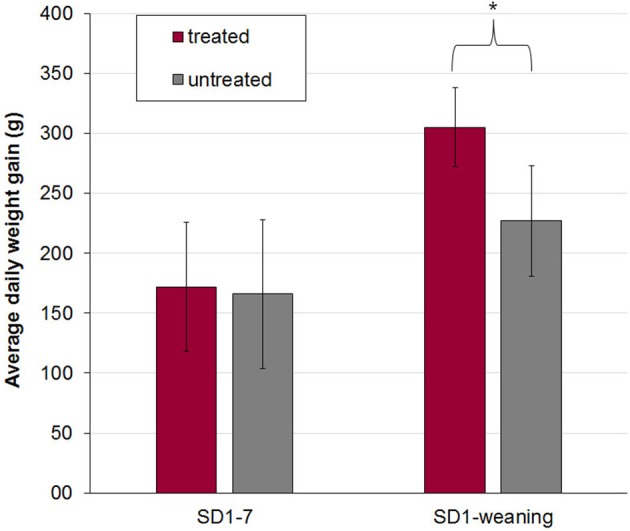
Mean and standard deviation of average daily weight gain in treated (n = 16) and untreated (n = 17) piglets out of four litters from birth to day 7 (SD 1–7, litter 1–4) and from birth to weaning (SD 1-weaning, litter 1 and 2). The bacterial cocktail was applied orally to half of the piglets of each litter immediately after birth and on day two and three of life. The other half of the piglets served as a control group and got 154 mM NaCl. Asterisk indicates a significant difference between treated and untreated piglets. In litters 3 and 4 all piglets had to be treated after day 10 of life due to respiratory disease or arthritis and were excluded from further evaluation of body weight development.